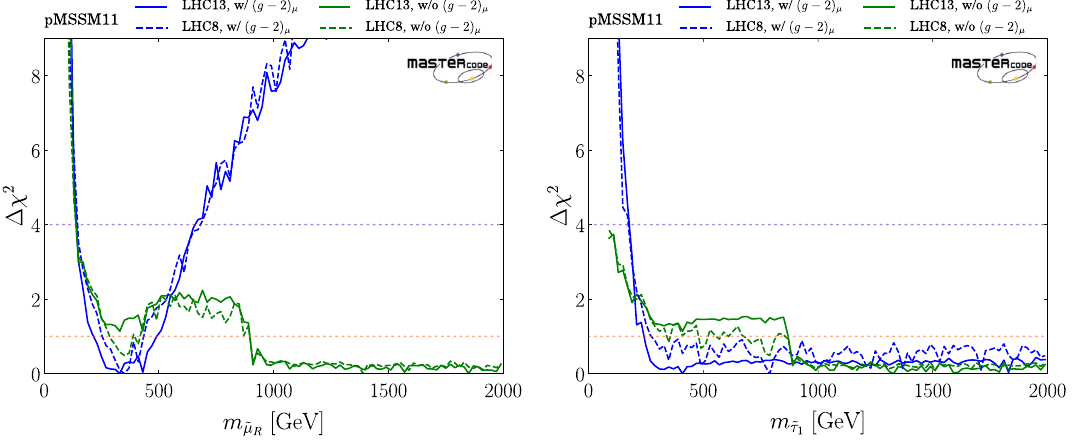
Fig. 10 Left panel: One-dimensional profile likelihood functions for the ˜ μ R mass in the pMSSM11 with (blue) and without the ( g − 2 ) μ constraint (green) and with (solid) and without (dashed) applying the constraints from LHC Run II. Right panel: Similarly for the ˜ τ 1